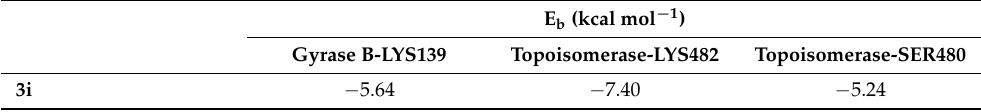
Table 4. Binding energies for best docking conformation of 3i with Gyrase B and topoisomerase II beta.